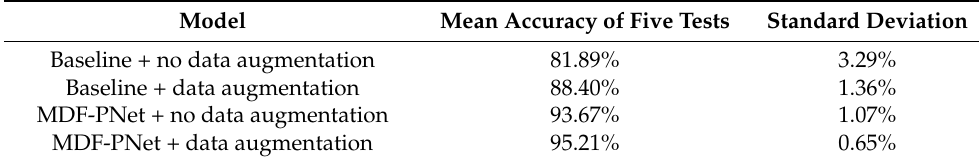
Figure 12. Cross-test the combination of two conditions. ( a ) baseline and ( b ) MDF-PNet. Table 5. Comparison of accuracy after cross-test. Table 5. Comparison of accuracy after